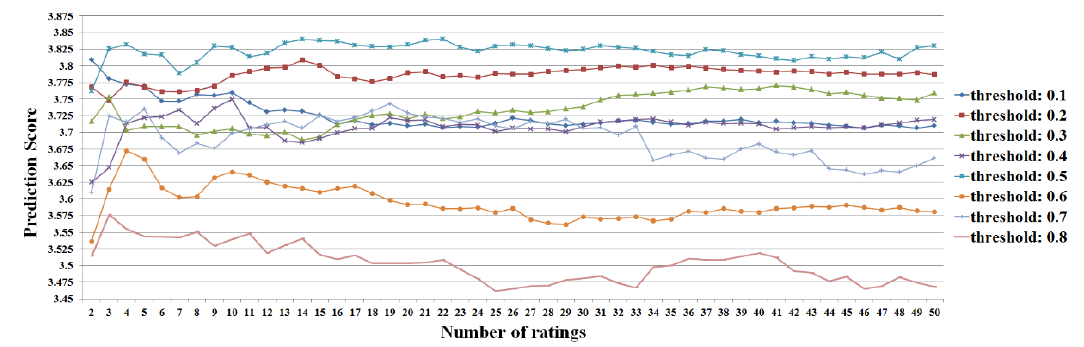
Figure 2. Results of the prediction scores based on the Pearson correlation coefficient in the user-based filtering.